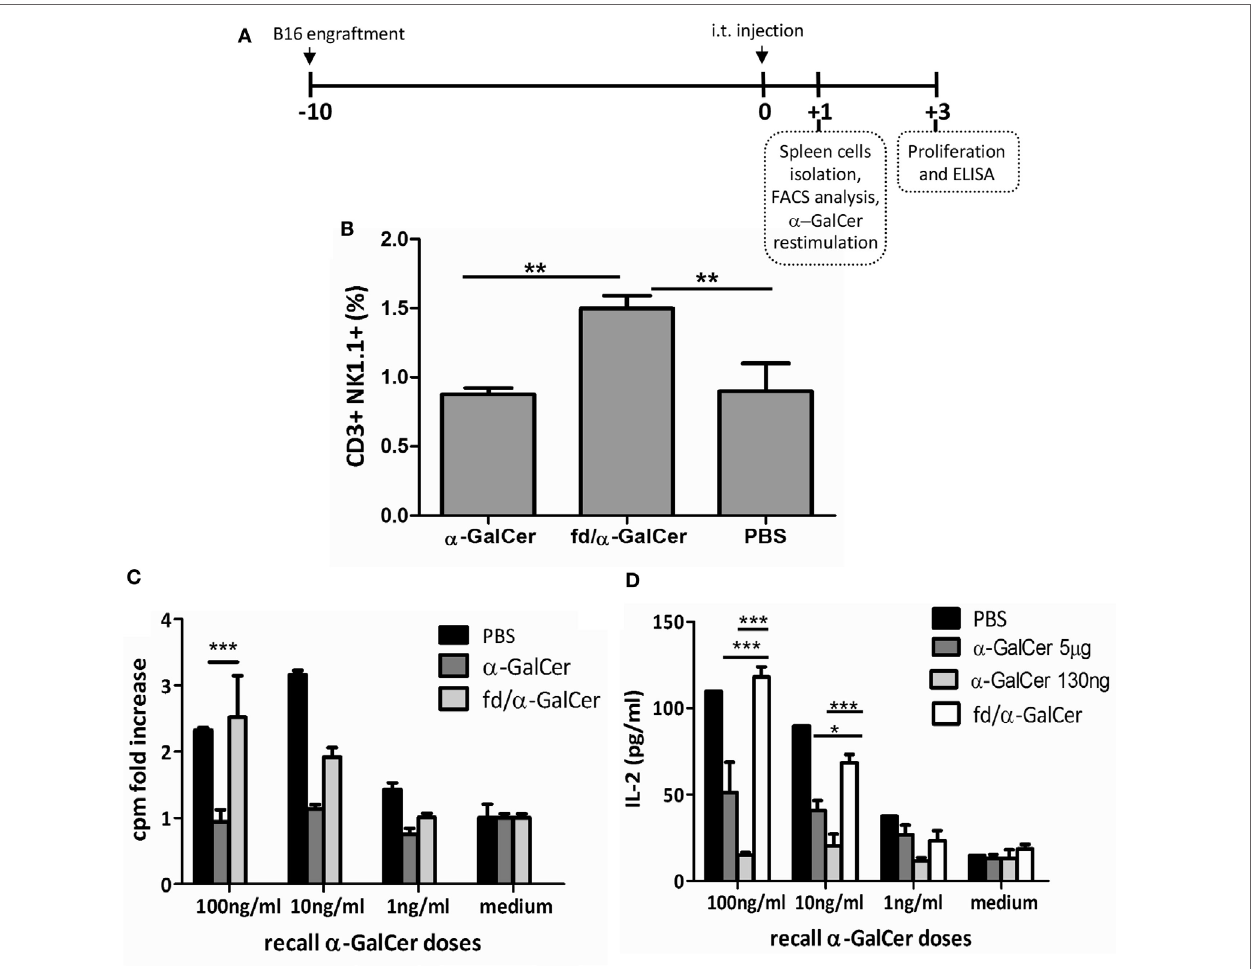
FigUre 4 | Invariant natural killer T response in mice injected intratumorally with fd-vectorized alpha-GalactosylCeramide ( α -GalCer). Mice were inoculated with B16 melanoma cells and when tumor was palpable, mice were intratumorally injected with free α -GalCer, α -GalCer delivered by phage particles or vehicle alone, and sacrificed after 24 h. (a) Schematic representation of the experiment schedule. (B) CD3 + NK1.1 + cells were evaluated in freshly isolated spleen of injected mice by FACS analysis and staining with anti-NK1.1 and anti-CD3 antibodies. Percentage of NK1.1 + CD3 + positive cells ± SD is reported. p < 0.01 by one-way analysis of variance (ANOVA) followed by a Dunnett’s multiple comparison test. ** p < 0.01. (c,D) Splenocytes were cultured with graded doses of α -GalCer. After 3 days, proliferation was assessed by [3H] thymidine incorporation (c) , and culture supernatants were evaluated for IL-2 release by ELISA (D) . Average + SEM is reported. p < 0.001 by two-way ANOVA and the Bonferroni multiple comparison test. * p < 0.05, *** p <